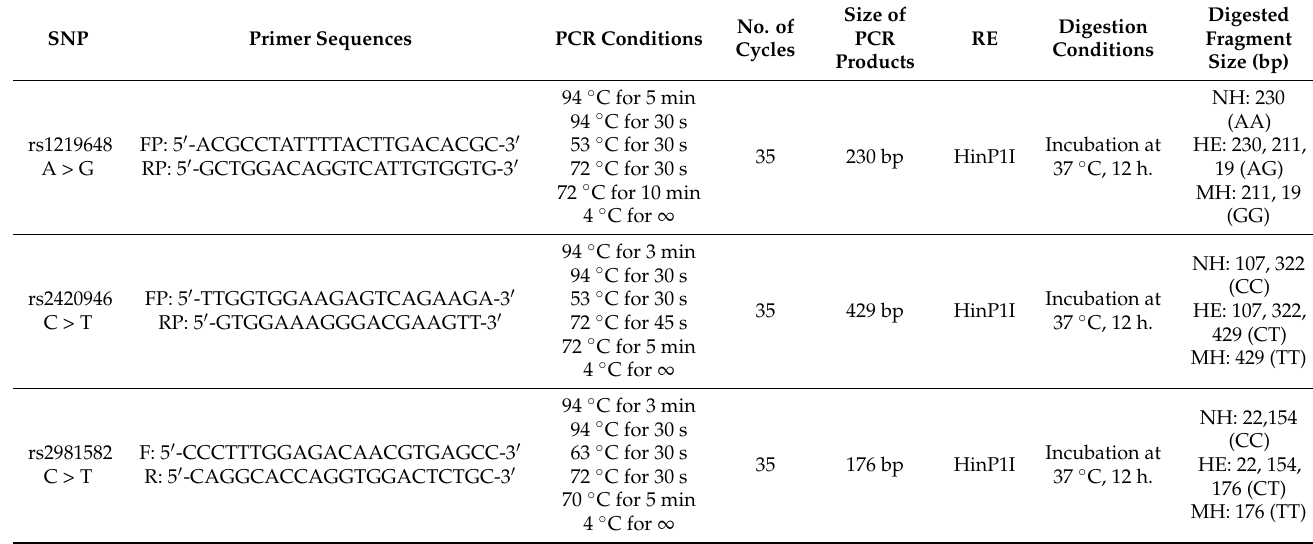
Table 1. Primers, PCR, and digestion conditions with respective fragment